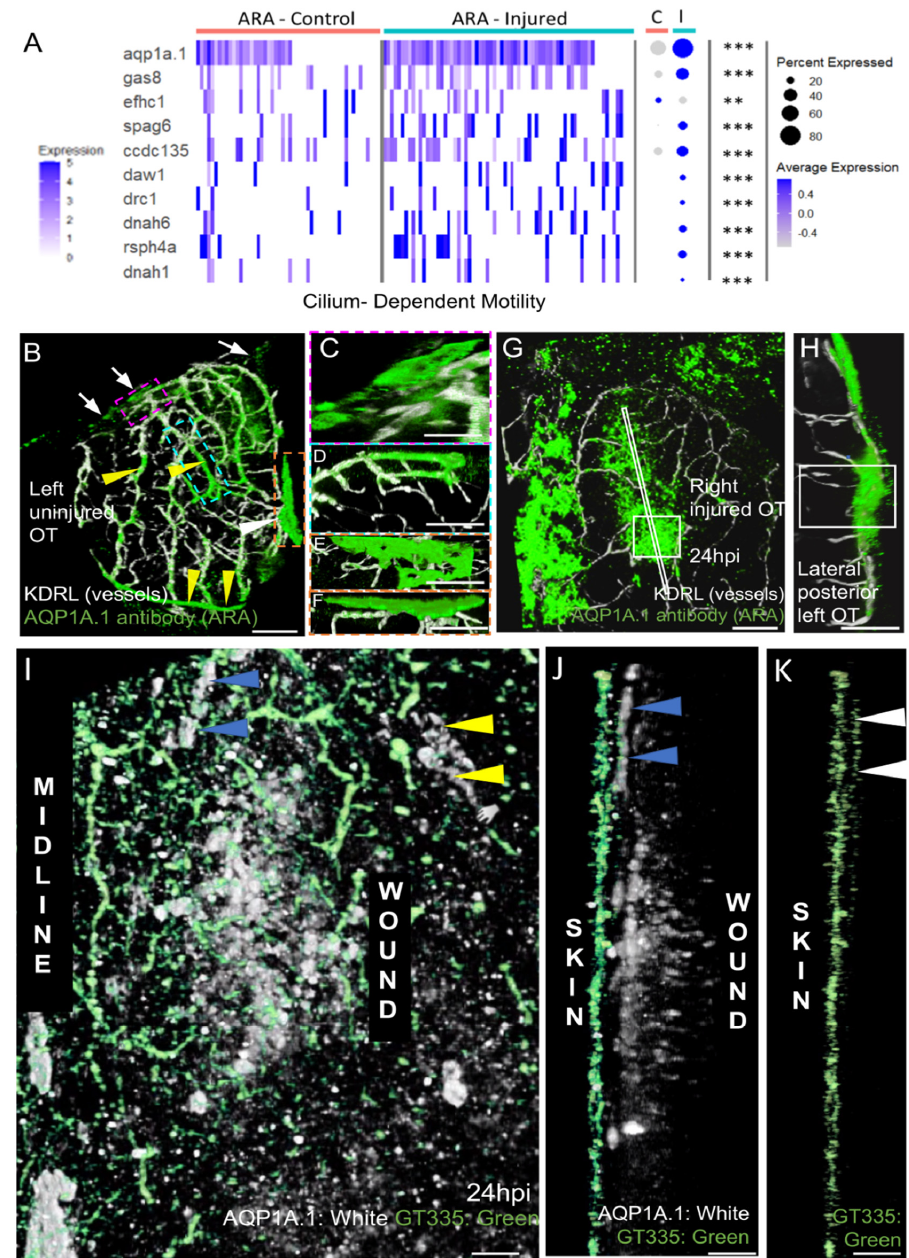
Figure 8. AQP1a.1 ciliated ARA migrates towards the wound. ( A ) Expression of AQP1a.1 and cilia motility genes in cells depending on their status show overexpression of these genes after wounds. Genes expressed <10% of cells are not presented in dotplot. Adjusted p value (** <0.01 *** <0.001) concern markers in injured status. ( B ) Dorsal view on an uninjured OT with ARA (white arrows), MID (white arrowhead), and vessels (yellow arrowheads) stained by the AQP1a.1 antibody. Anterior at the top. Midline on the left. ( C ) Detailed dorsal view of ARA. ( D ) Detailed side view of ARA. ( E ) Detailed dorsal view of MID. ( F ) Detailed side view of MID. ( G ) At one dpi, strongly positive AQP1a.1 cells are visible over the wound (white arrowheads). ( H ) Strong and thick AQP1a.1 staining over the wound. ( I ) AQP1a.1-positive cells over and around the wound. Peripheral ARA-like cells: yellow arrowheads. ( J ) Migrating ARA stained by AQP1a.1: blue arrowheads. Lateral ARA: yellow arrowheads. ( K ) Migrating AQP1a.1-positive ARA are ciliated as shown by the GT335 staining: white arrowheads. AQP1a.1-positive cells do not exhibit any cilium/GT335 staining. Scale bars: ( A , F ): 100 µ m; ( B – E , G ): 50 µ m; ( H – J ): 10 µ